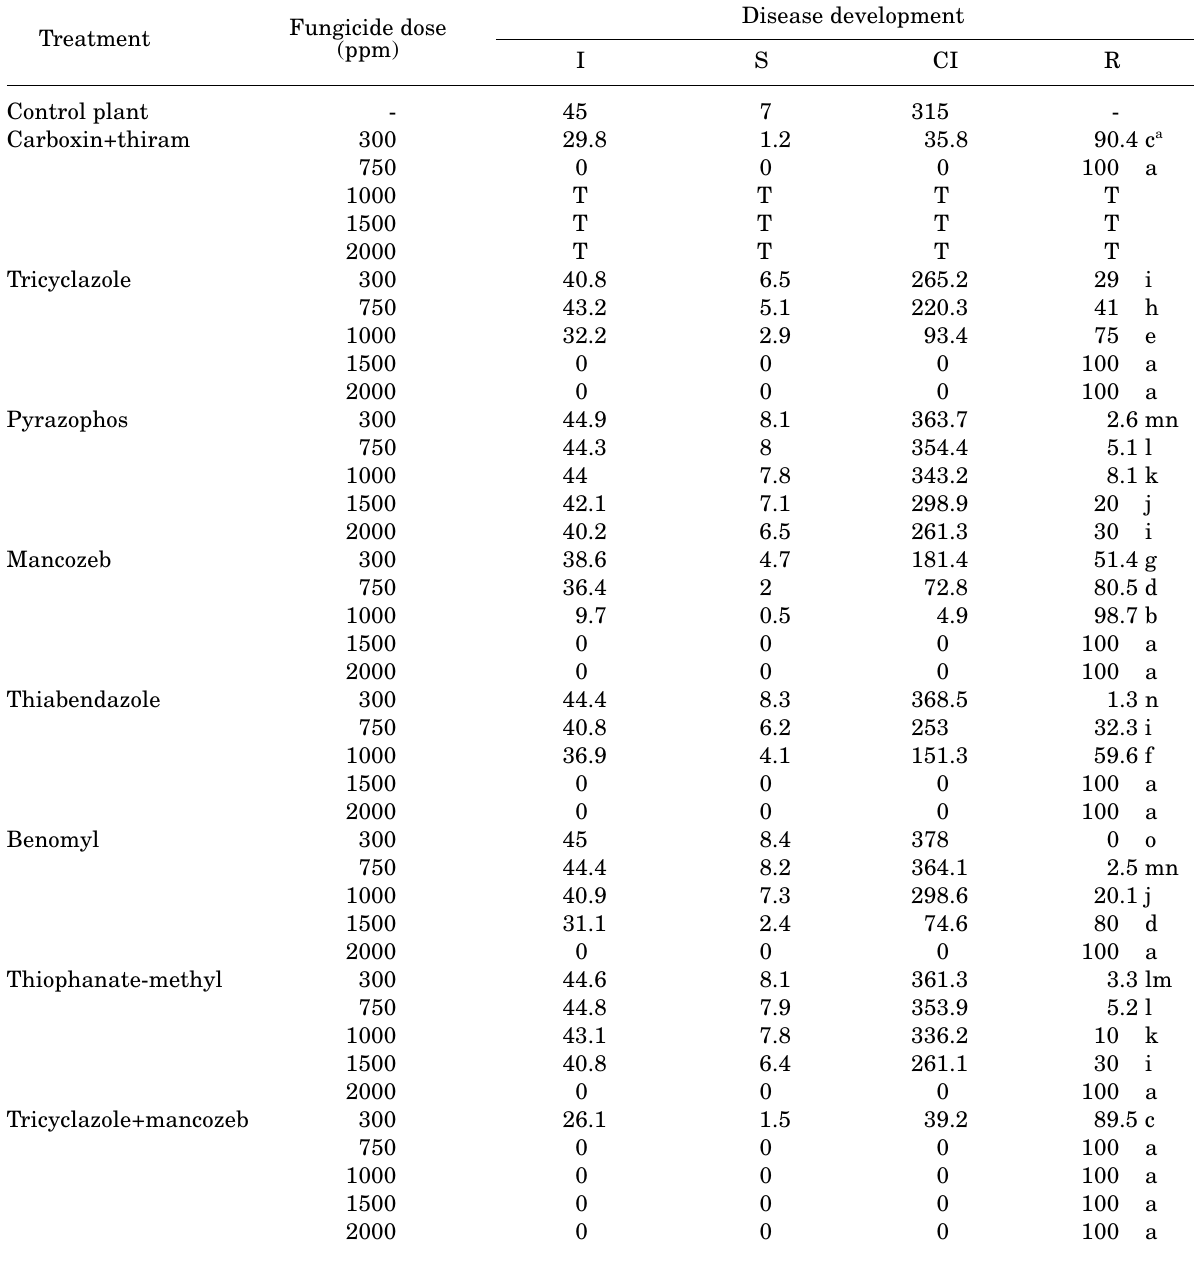
Table 7.Disease incidence (I), severity (S) and infection coefficient (CI) induced by Helminthosporium oryzae on young rice plants treated with various doses of fungicides and percent disease reduction